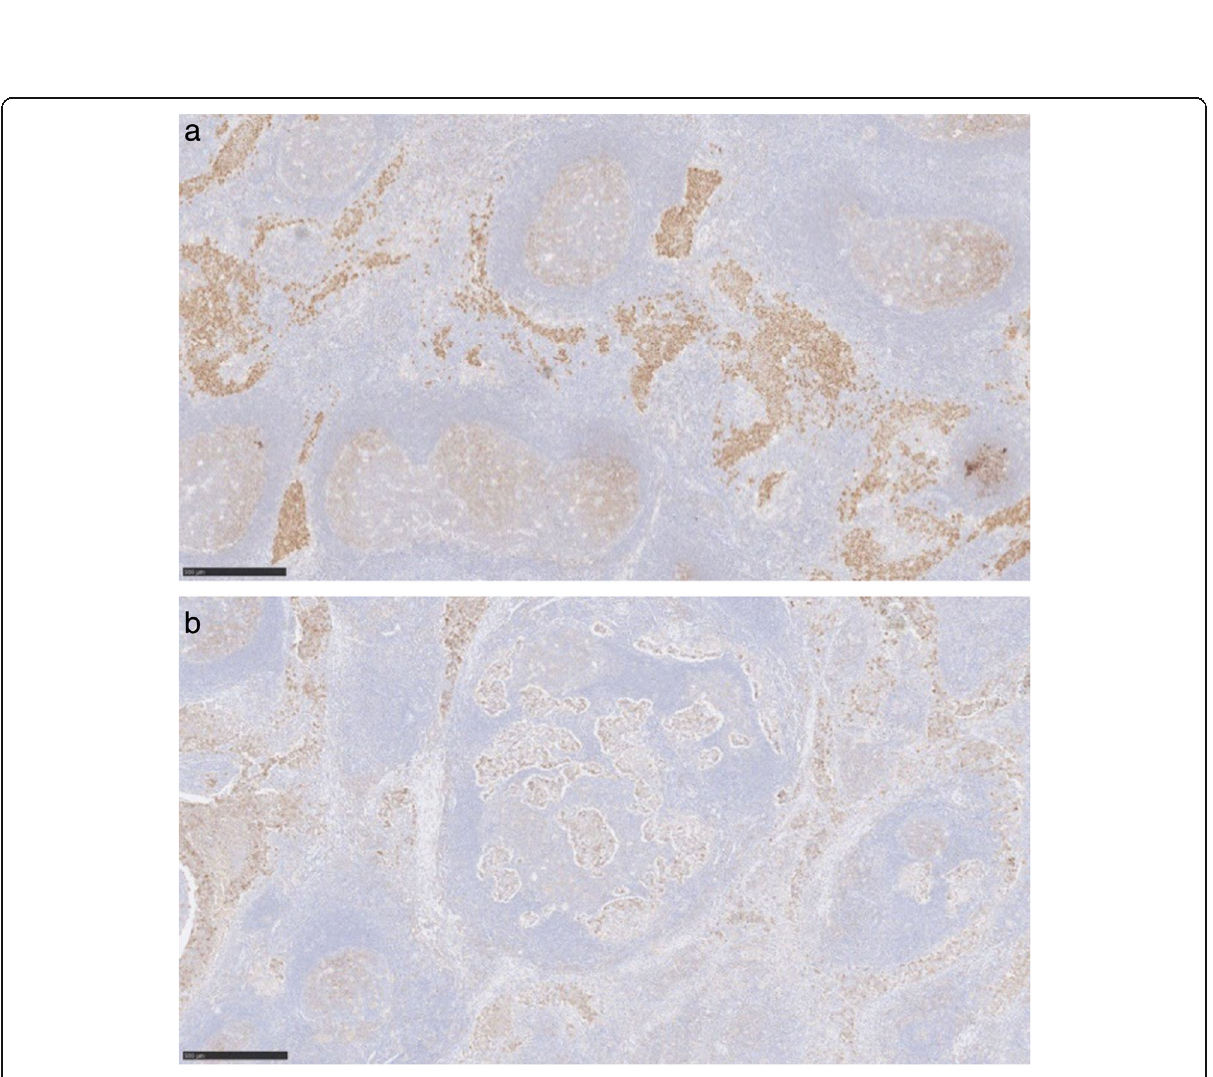
Fig. 5 Immunohistochemistry Oct4 (left) and PLAP (right), both images × 5 magnification, confirming the diagnosis of